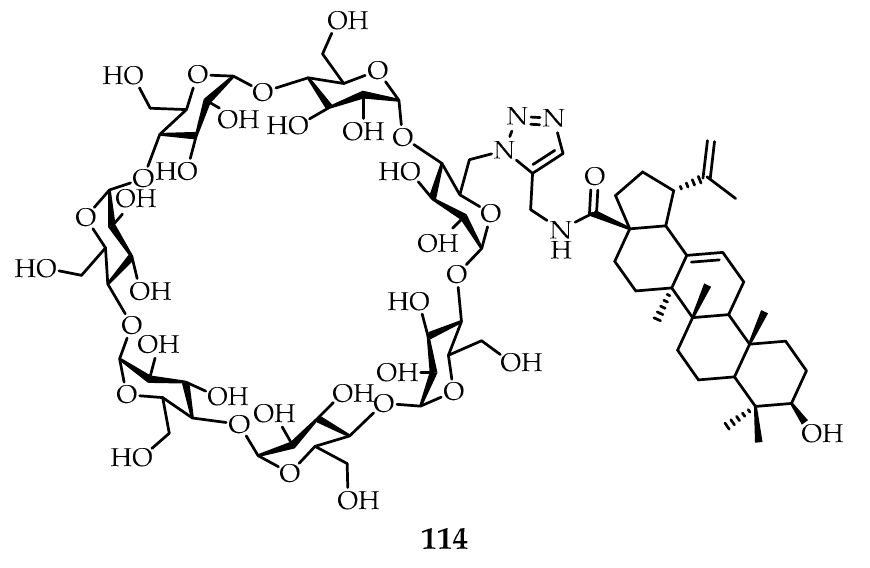
Figure 15. Structure of macrocycle 114 .